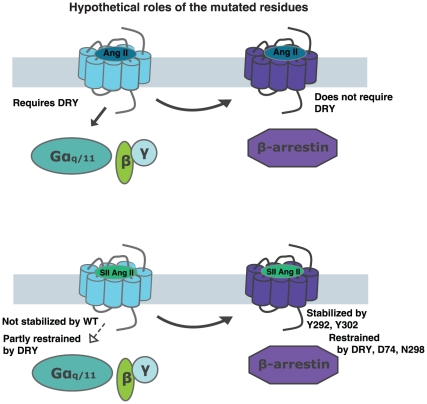
Schematic overview of different phenotypes of the mutants.Schematic presentation of how the residues mutated in this study could hypothetically affect the induction of different conformations. These interpretations are based on the data included in this study and should be considered with the precautions mentioned in the Discussion section.